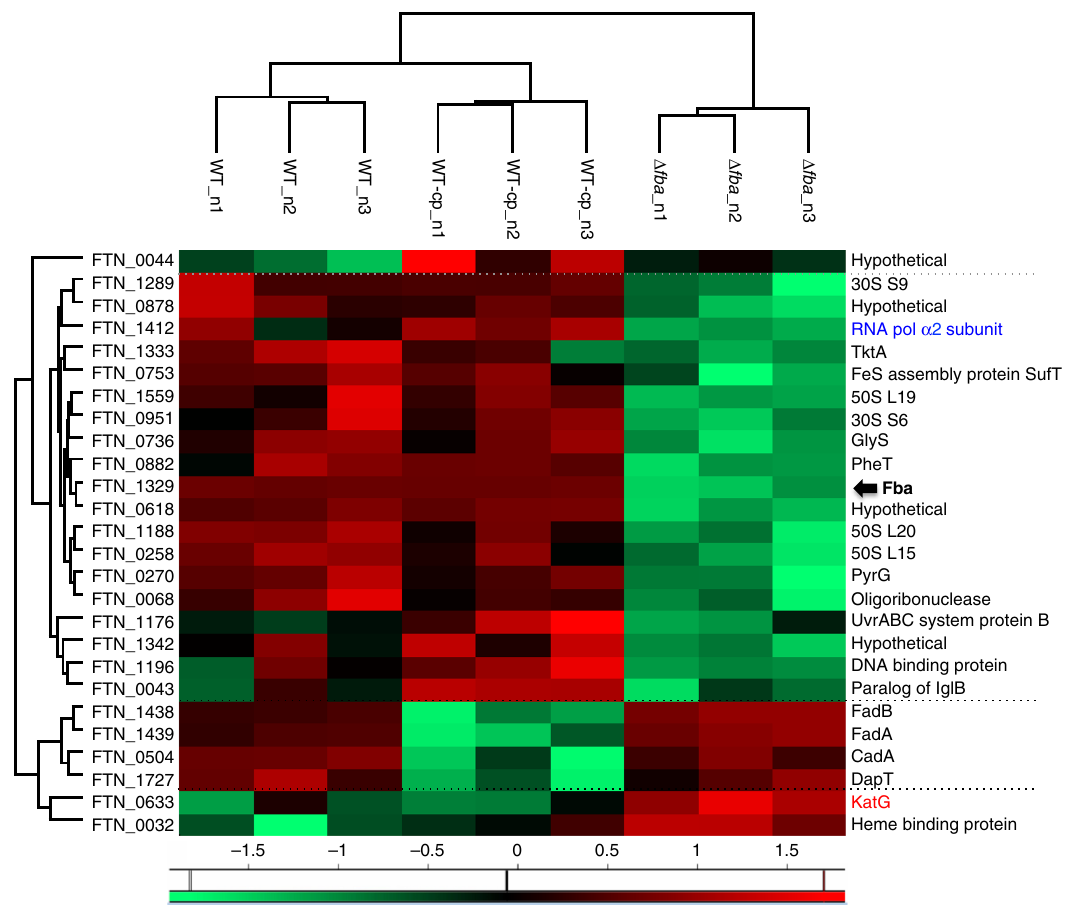
Fig. 6 Biclustering and heat map of differential proteins. Heat map and biclustering were obtained by comparing the 26 differentially expressed proteins identi fi ed from label-free MS analysis of WT, Δ fba , and WT-complemented (WT-Cp) strains. To the left , FTN protein numbers; to the right , corresponding predicted functions. FBA, in bold , is indicated by a black arrow ; RNA polymerase α 2 subunit (down-regulated in Δ fba ) is highlighted in blue , and KatG (up- regulated in Δ fba ) in